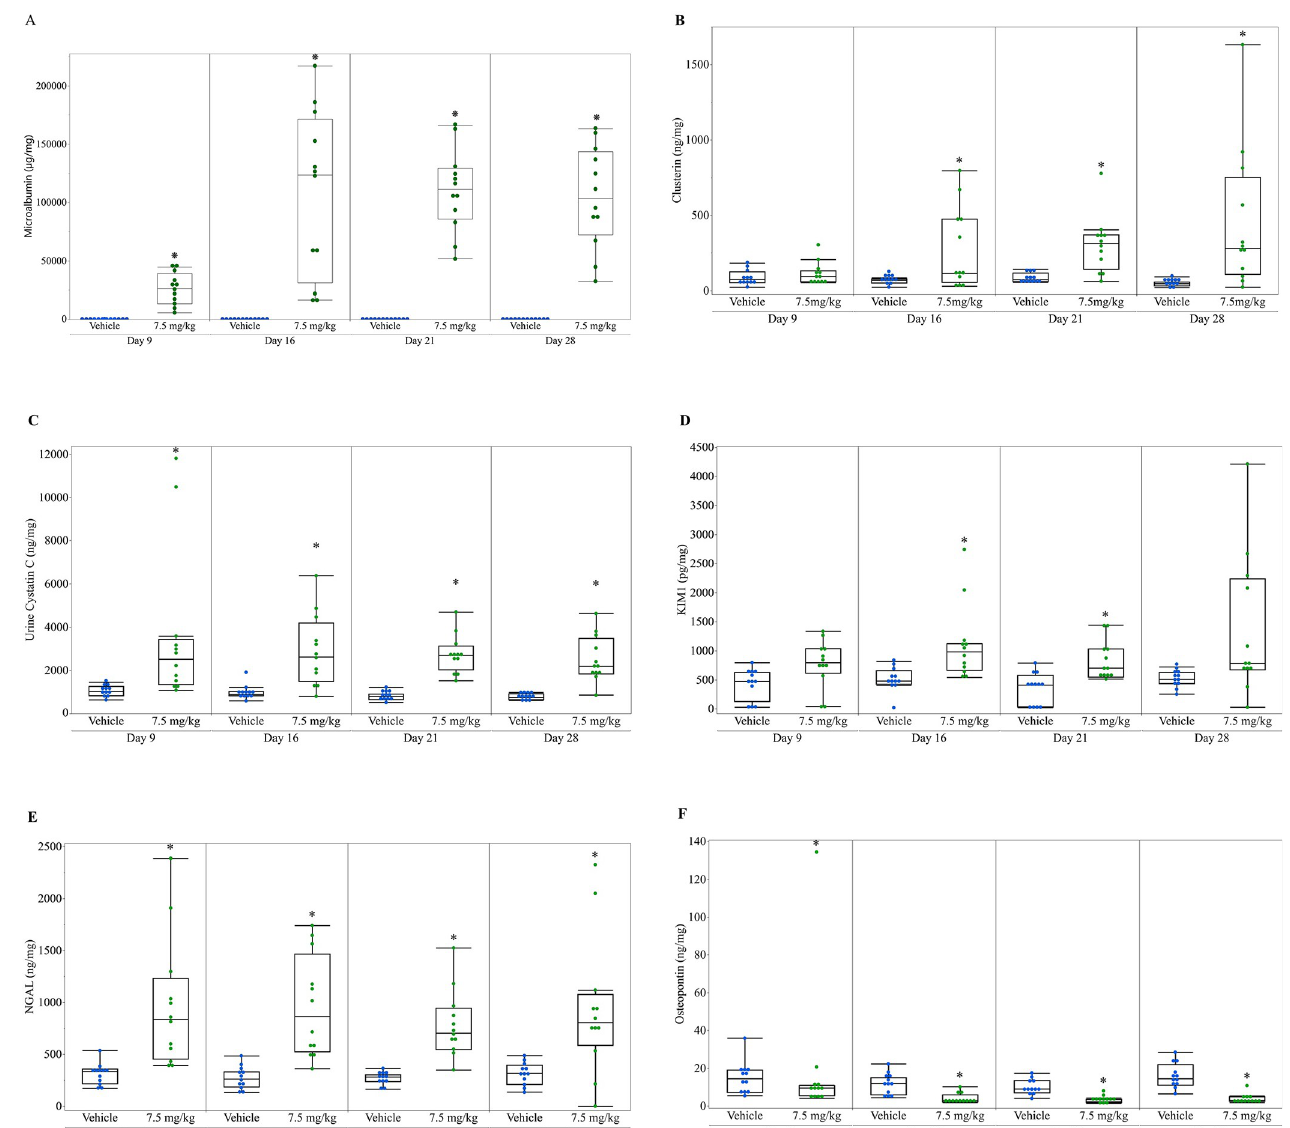
Fig 3. Urine renal biomarkers in control and anti-Fx1A-treated rats. A. Microalbumin ( μ g/mg); B. Clusterin (ng/mg); C. Cystatin C (ng/mg); D. KIM-1 (pg/ mg); E. NGAL (ng/mg); F. Osteopontin (ng/mg). Urine biomarker values were normalized to urine creatinine concentration. Horizontal line within the box represents the median sample value, box represents interquartile range (IQR), whiskers extend to 1.5x IQR. � Indicates treatment group is significantly different (p � 0.05) from vehicle control group at the same number of